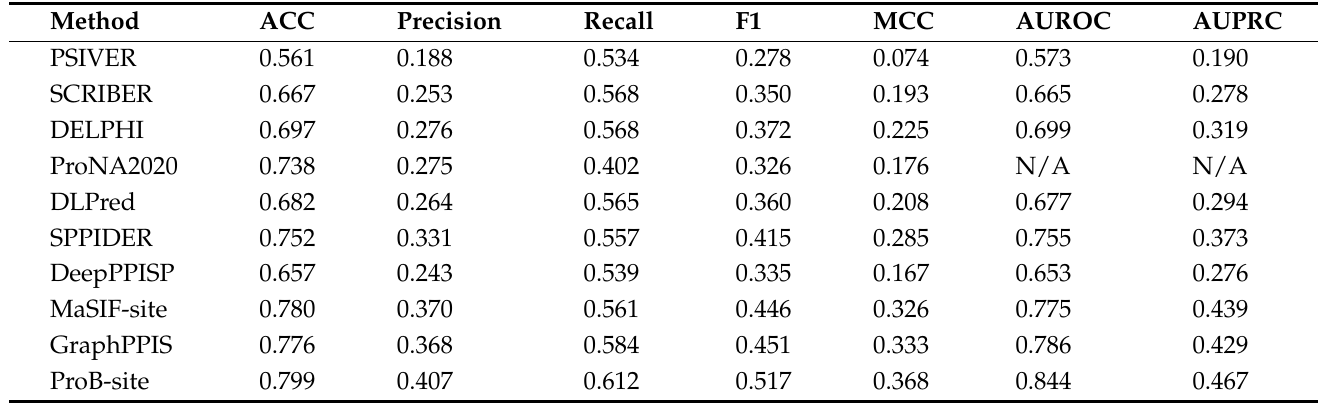
Table 3. Proposed model (ProB-site) compared with the previous techniques in the literature using Test_60 data